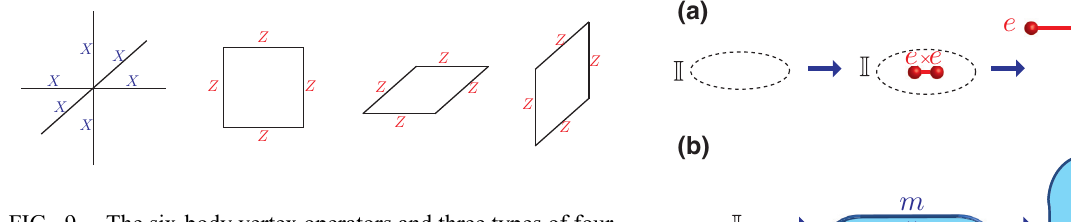
FIG. 9. The six-body vertex operators and three types of four- body plaquette stabilizers lying in the y - z , x - y , and x - z planes, respectively, in the 3D toric code model defined on a cubic lattice.